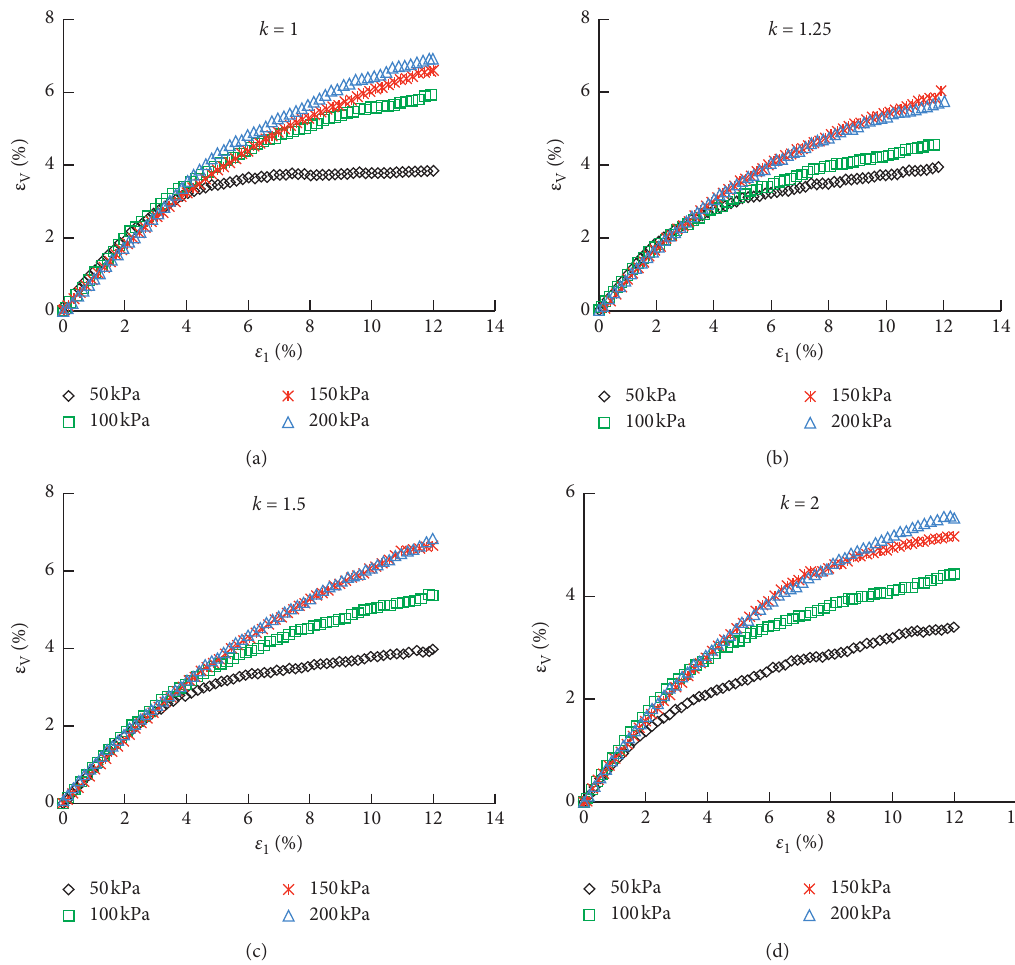
Figure 6: ε v ∼ ε 1 curves of intact loess at different confining